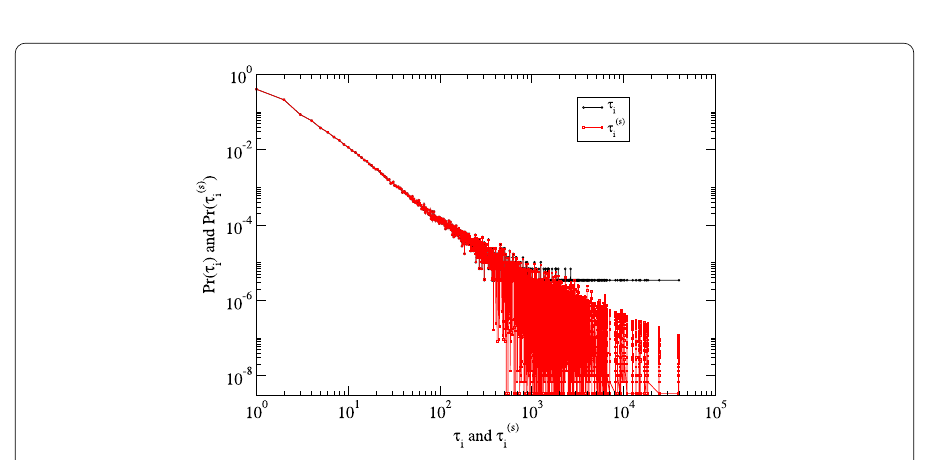
Figure 18 Distributions Pr( τ i ) (black ‘ ◦ ’) and Pr( τ ( s )